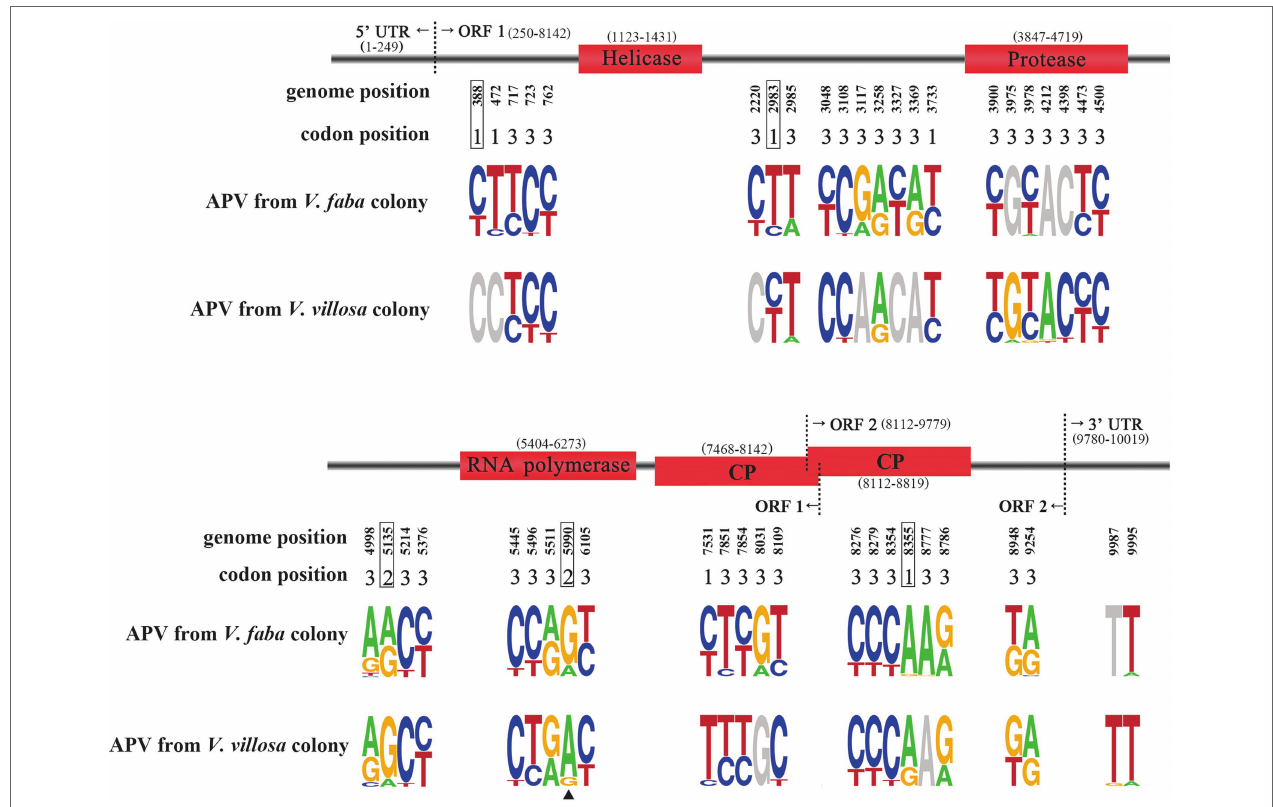
FIGURE 1 | Sequence logo showing allele frequencies at 46 SNP sites in APV genomes from the pea aphids Vicia faba colony and Vicia villosa colony. The genome position and corresponding codon position for each SNP are shown. Four domains are marked in red rectangles. Five SNPs resulting in nonsynonymous mutations are boxed. Site 5,990 is marked with a triangle. A logo represents each column of the alignment by a stack of letters, with the height of each letter proportional to the observed frequency of the corresponding